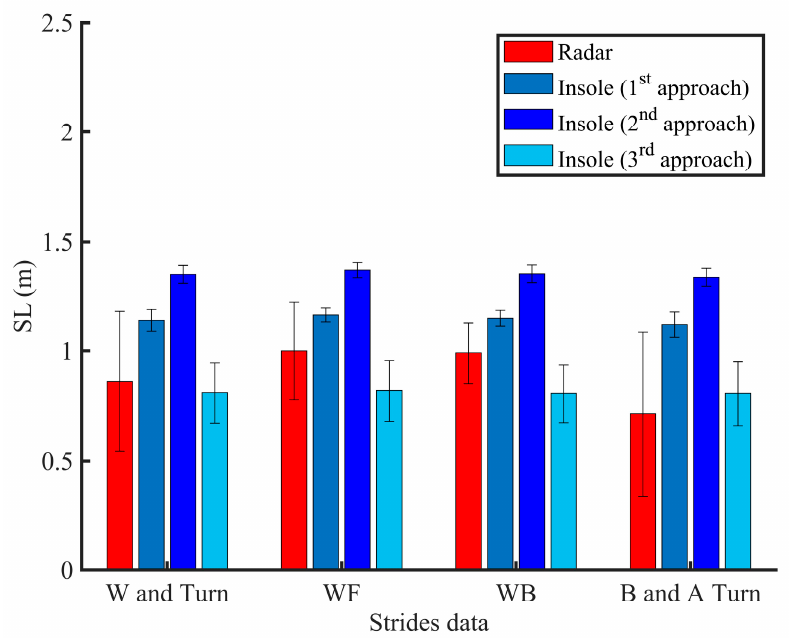
Figure 10. Stride length (SL) estimation during the TUG test using different approaches and technologies (W: walking; WF: walk forward; WB: walk back; B and A Turn: strides before and after turning).